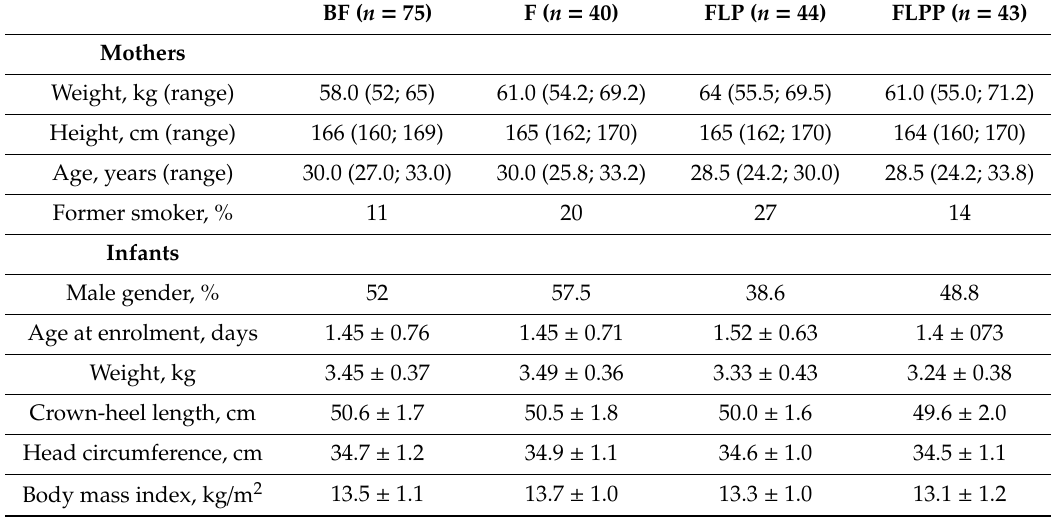
Table 1. Baseline characteristics of the 202 healthy term infants included in the